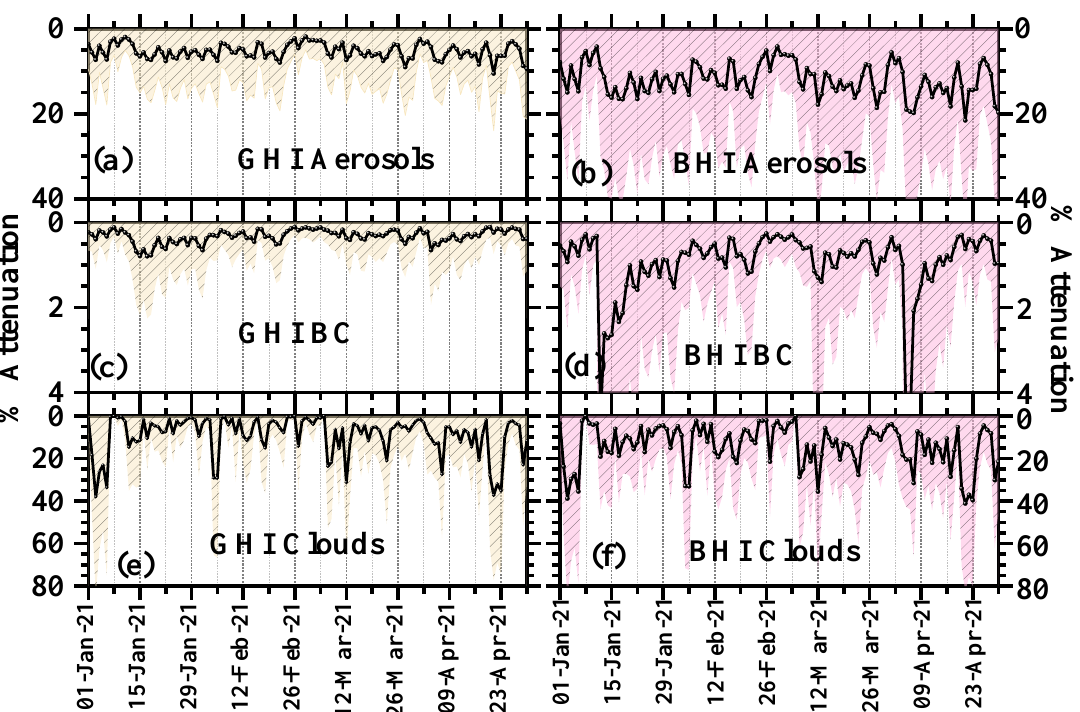
Figure 12. Time-series plots of percentage attenuation of GHI Aerosols ( a ), BHI Aerosols ( b ), GHI BC ( c ), BHI BC ( d ), GHI Clouds ( e ), and BHI Clouds ( f ). The shaded colors show the ±1 standard deviations.